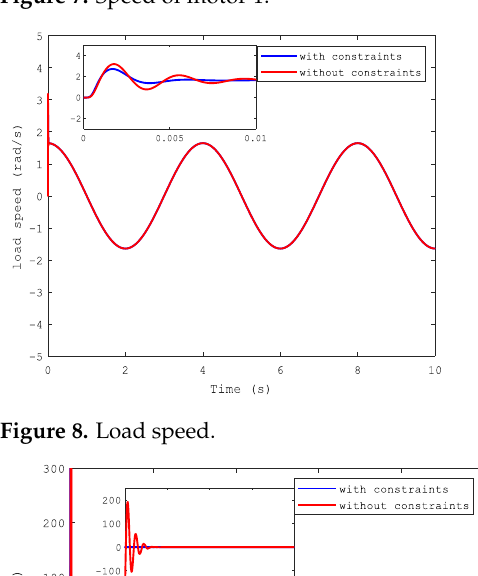
Figure 7. Speed of motor 1.